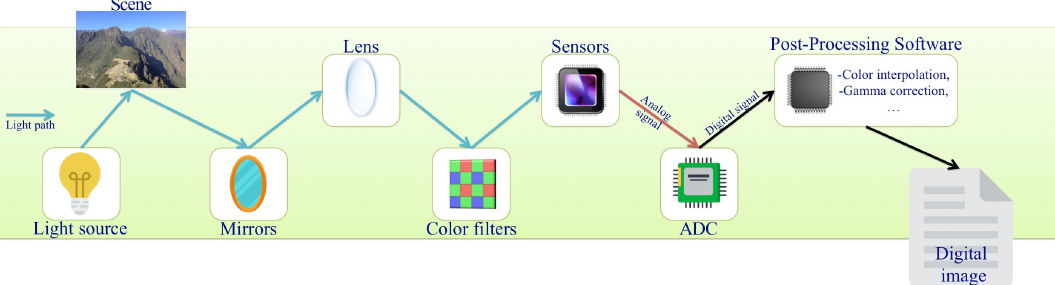
Figure 2. Image formation process. CFA interpolation artifacts are introduced by color